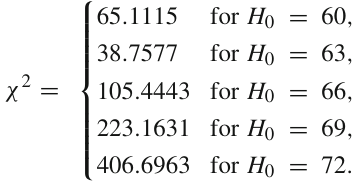
plotted in Fig. 10. The error bars representing observations given in [83] are also added to the figure for comparison. The estimated values for different parameters for minimum χ 2 have been computed as H (cid:6) ( 0 ) = 1, λ = 0 . 334, μ = 0 . 0001 and α = 0 . 001 , ω = − 1 / 3 , (cid:15) DE 0 = 0 . 7 and β is given in Eq. (65) for five different values of H 0 = 60 (purple), 63 (magenta), 66 (green), 69 (orange), 72 (black). The values of χ 2 obtained for different values of H 0 as